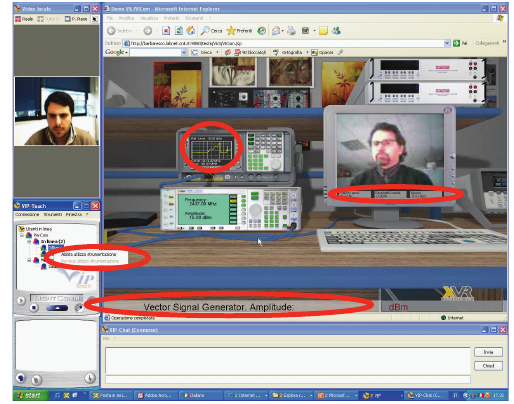
Figure 12: GUI in the many-to-one telemeasurement session.